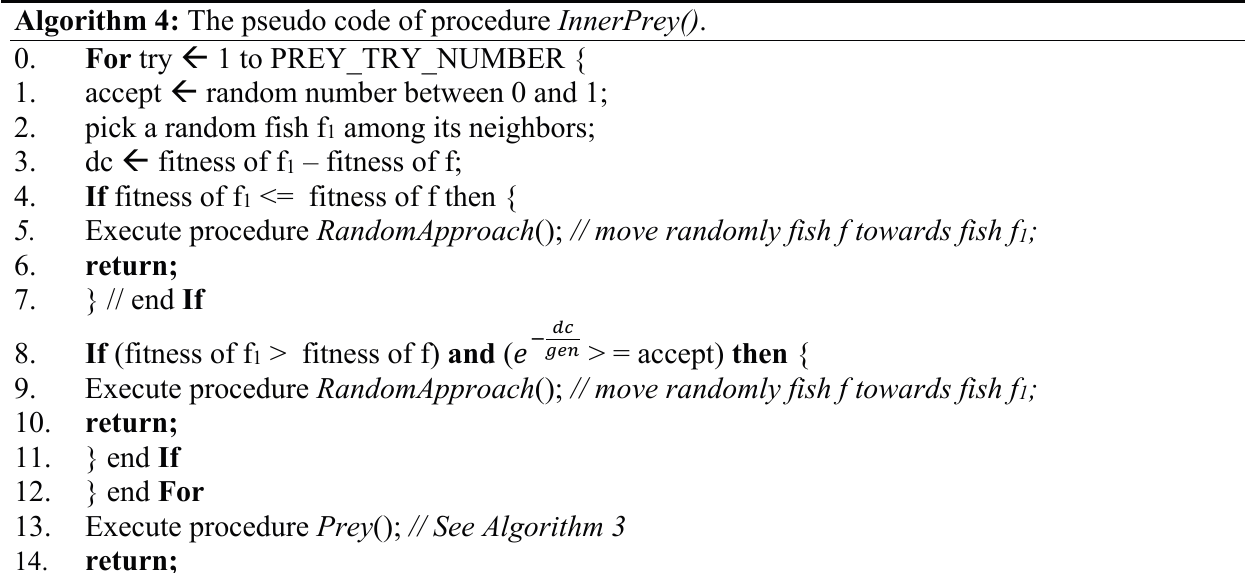
Algorithm 4: The pseudo code of procedure InnerPrey() .